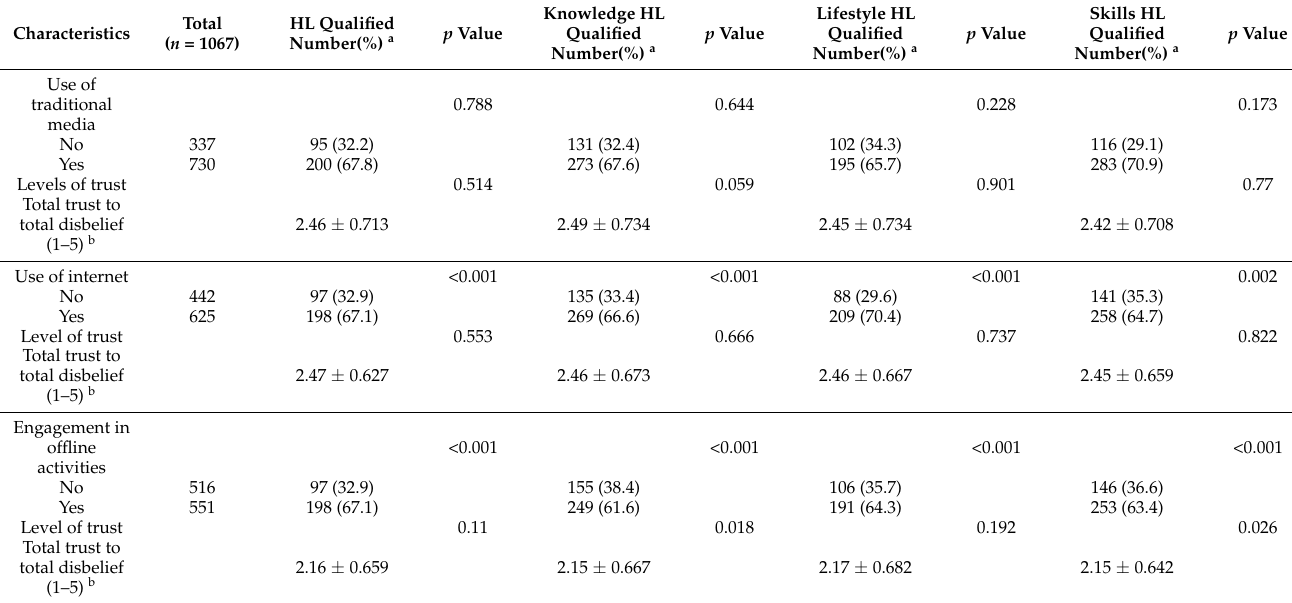
Table 2. Distribution and comparison of use of and trust in information channels according to health literacy